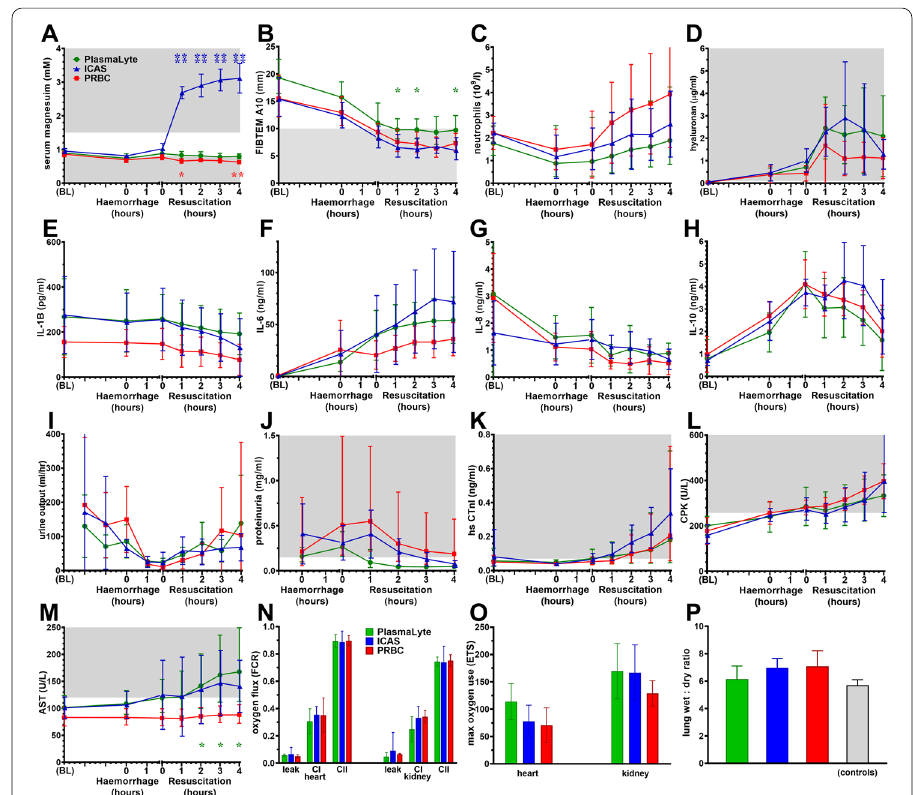
Fig. 6 Treatment effects on inflammation and organ function. A Serum magnesium. B 10 min ROTEM amplitude (A10) in FIBTEM. C Circulating neutrophil count. D Serum hyaluronan; inflammatory cytokines in plasma ( E ) IL‑1β, ( F ) IL‑6, ( G ) IL‑8, and ( H ) IL‑10. I Urinary output. J Proteinuria. K Serum cardiac troponin‑I. L Serum creatine phosphokinase. M Serum aspartate aminotransferase. N Cardiac and renal tissue mitochondrial oxygen consumption (FCR: flux‑controlled ratio), background vs. complex I and II. O Total mitochondrial electron transfer capacity; and ( P ) lung wet/dry ratios. Data shown as mean or geometric mean according to normality test, with 95% confidence intervals. Mixed model ANOVA with Tukey correction for multiple comparisons; * p < 0.05, ** p < 0.01, *** p < 0.001, **** p ,